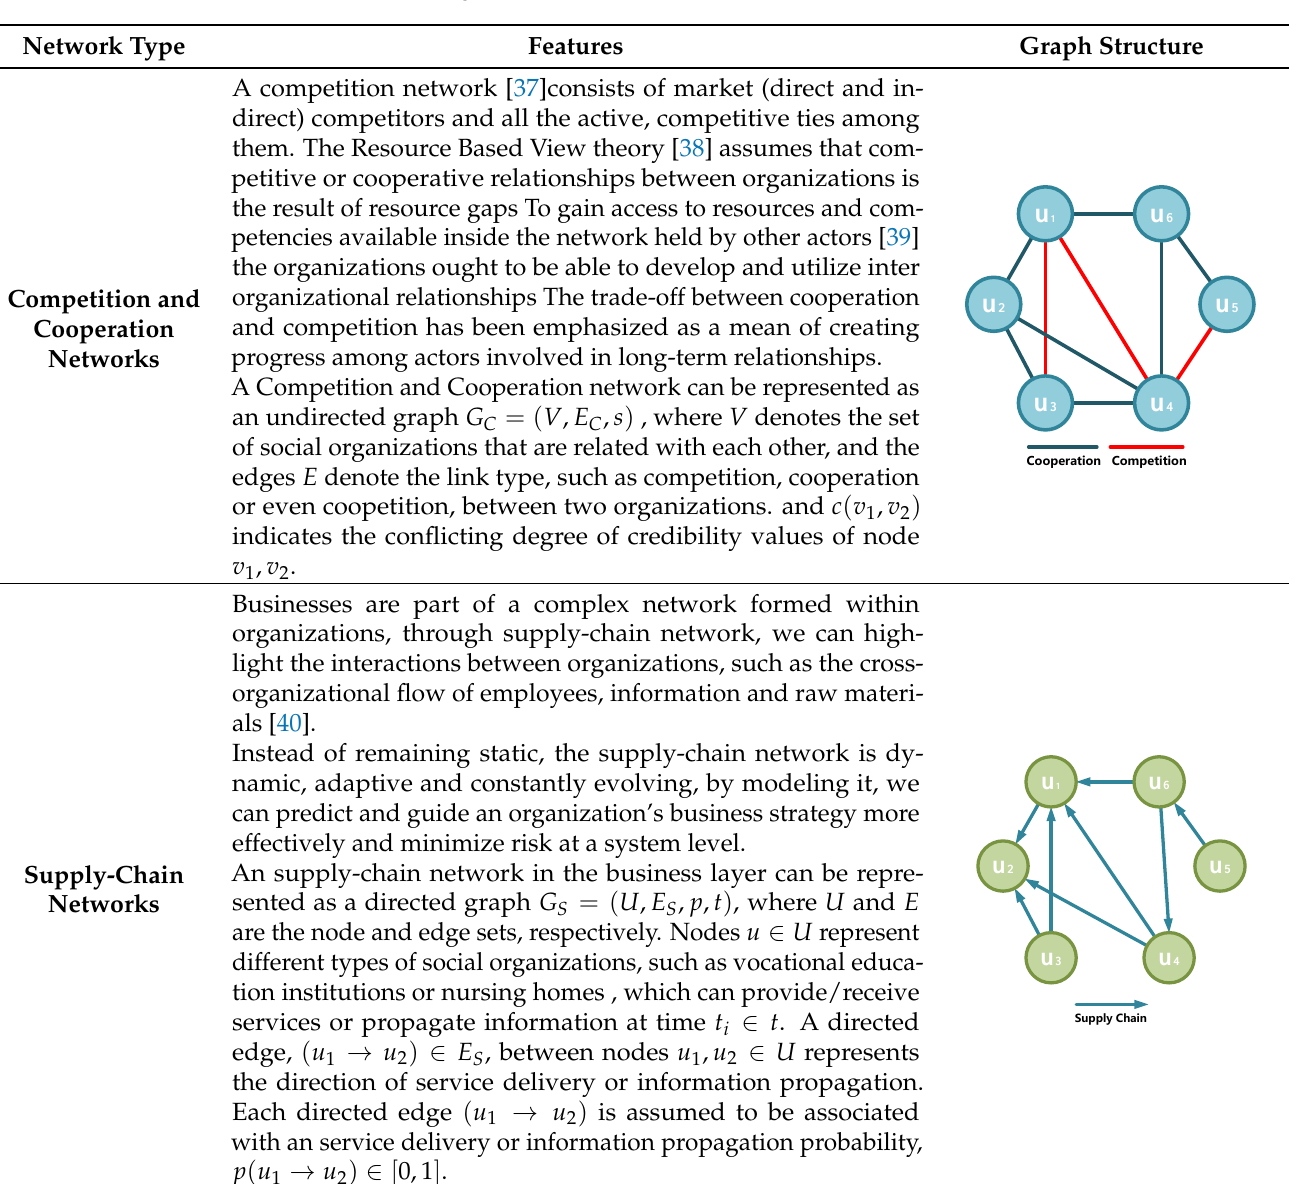
Table 4. Homogeneous